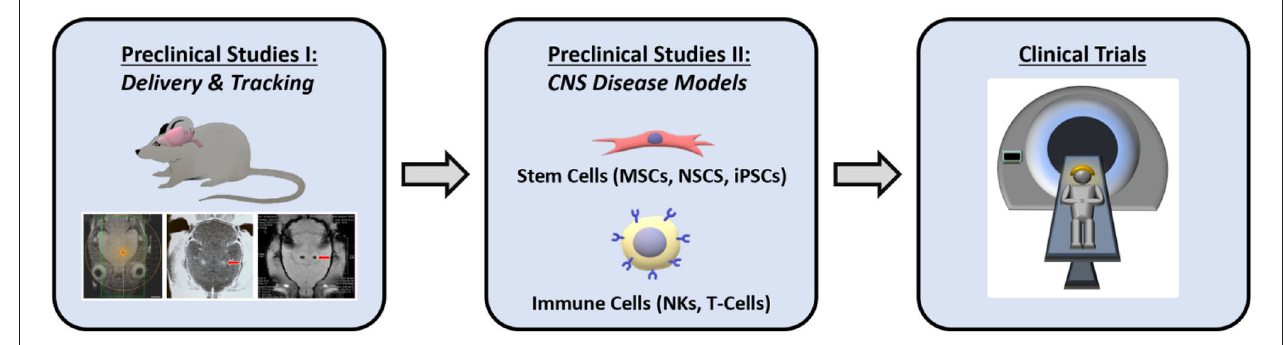
FIGURE 6 | Schematic representation of the anticipated preclinical and clinical stages involved for clinical translation in using MRgFUS for enhancing cellular